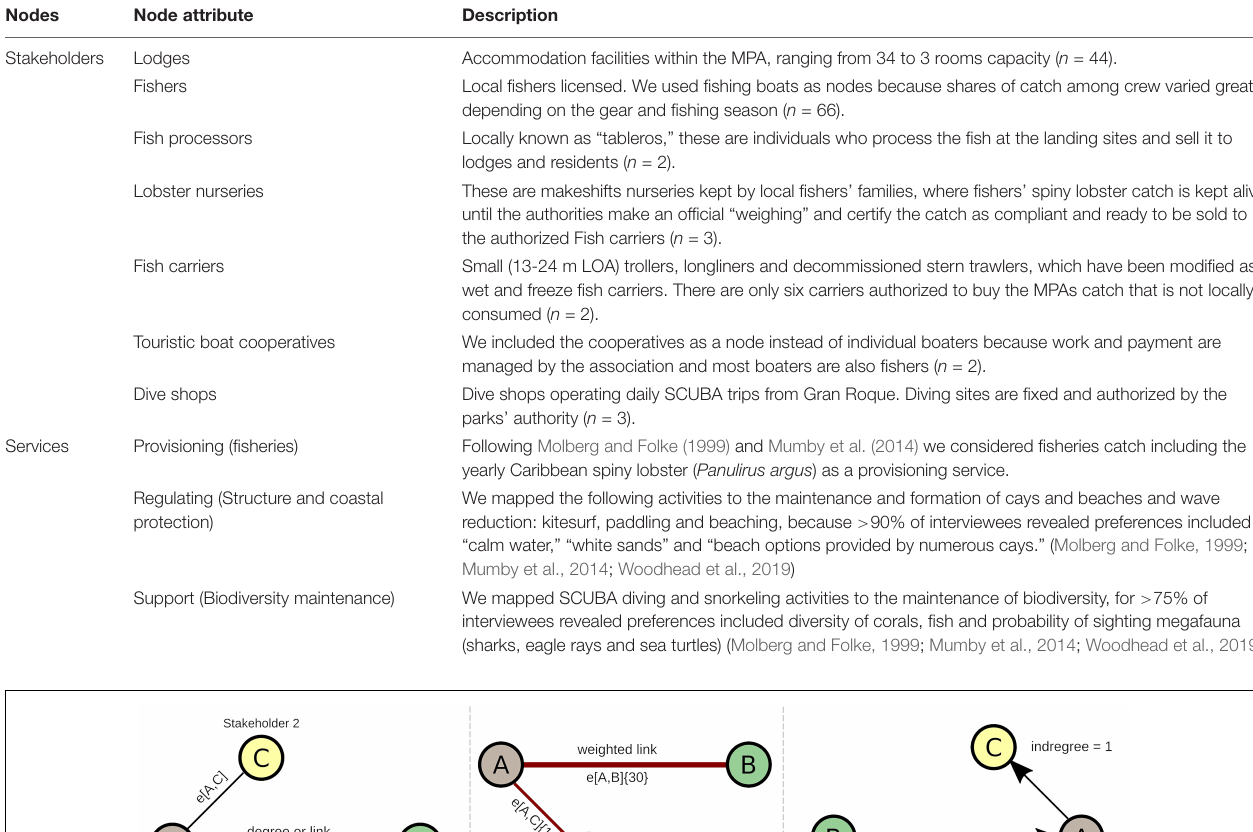
TABLE 1 | Nodes within a Socio-Ecological Network (SEN) based on the flow of economic benefits derived from fisheries and tourism, the main human uses within Los Roques National Park, a multi-use MPA in the southern Caribbean. Nodes